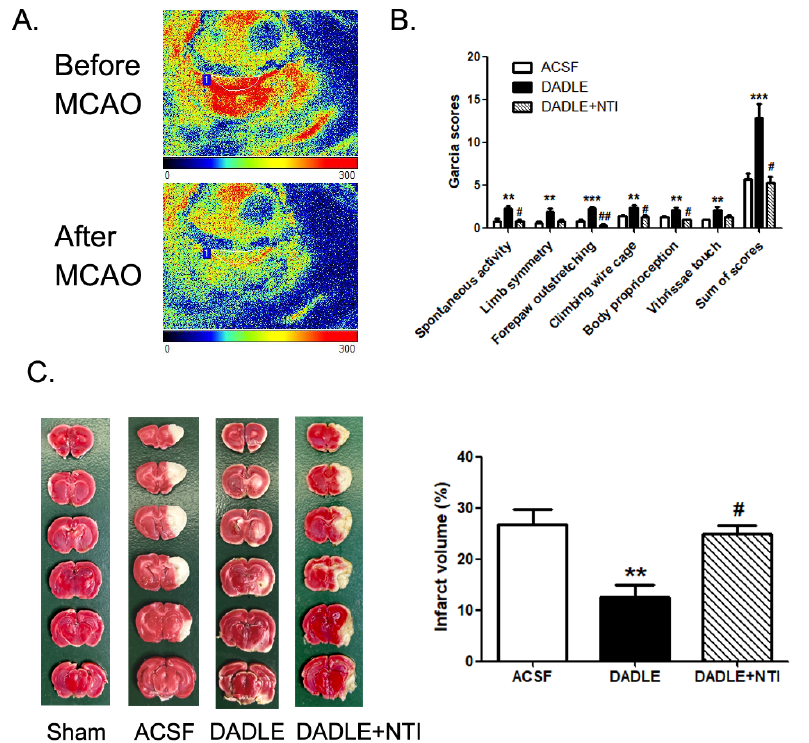
Figure 1. δ OR agonist [D-ala 2 , D-leu 5 ] enkephalin (DADLE) could reduce MCAO/reperfusion-induced cerebral ischemic infarct volume and relieve neurological deficit. ( A ) cerebral blood flow heatmap shows the hemisphere occlusive effect caused by MCAO surgery. ( B ) Garcia’s scores present the sensory and motor neurologic function of the MCAO-model-rats pre-treated with artificial cerebrospinal fluid (ACSF) or 5 nmol/10 µ L DADLE or NTI (2.5 nmol/5 µ L) following with DADLE at 72 h post-surgery. ( C ) 2,3,5-triphenyl tetrazolium chloride (TTC) staining shows the percentage of the cerebral infarct volume (showing as the white area) of the rats from the sham group and 72 h after MCAO/R with pretreatment of ACSF or 5 nmol/10 µ L DADLE. The statistical column graph presents as mean ± S.E.M. ** p < 0.01, *** p < 0.001 versus the ACSF group. # p < 0.05, ## p < 0.01 versus the DADLE group Both the ACSF and DADLE groups contained data from nine rats. The DADLE+NTI group contained data from four